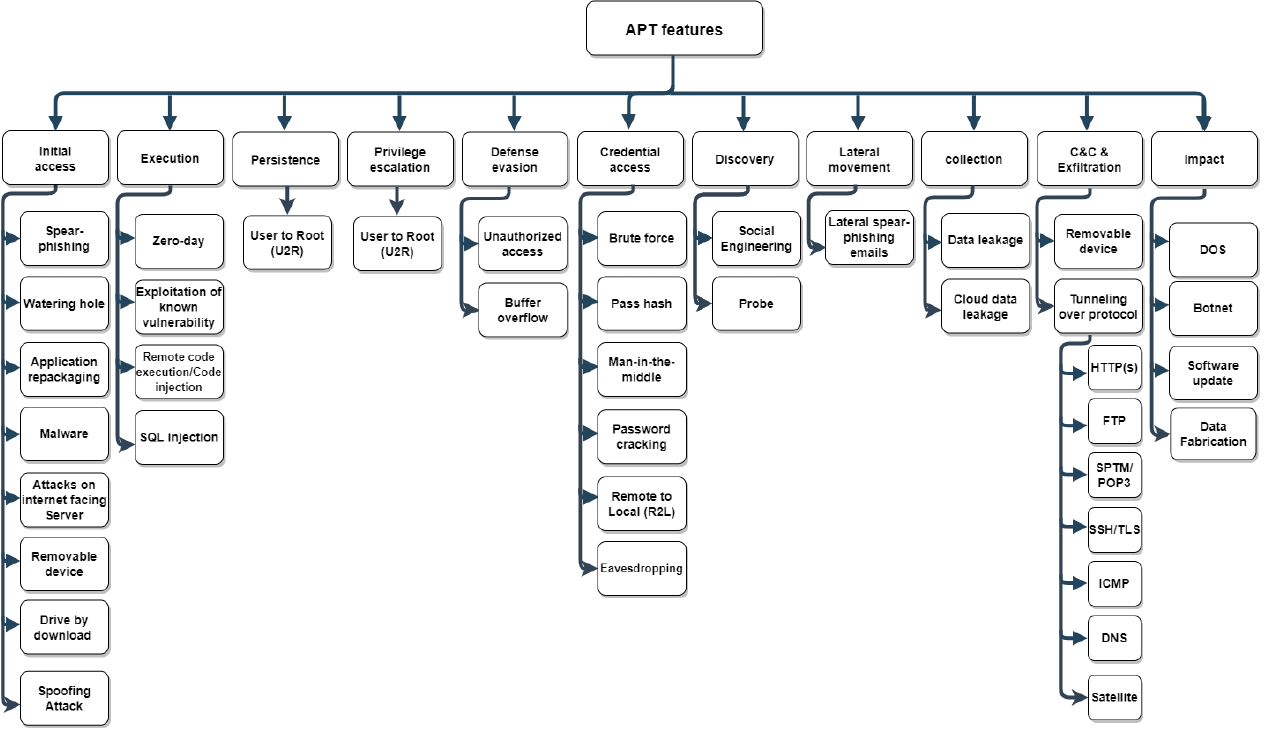
Figure 7. ATT&CK-based taxonomy of APT features.